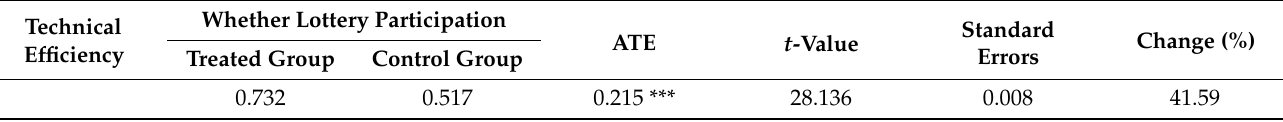
Table 6. Average treatment effect estimation